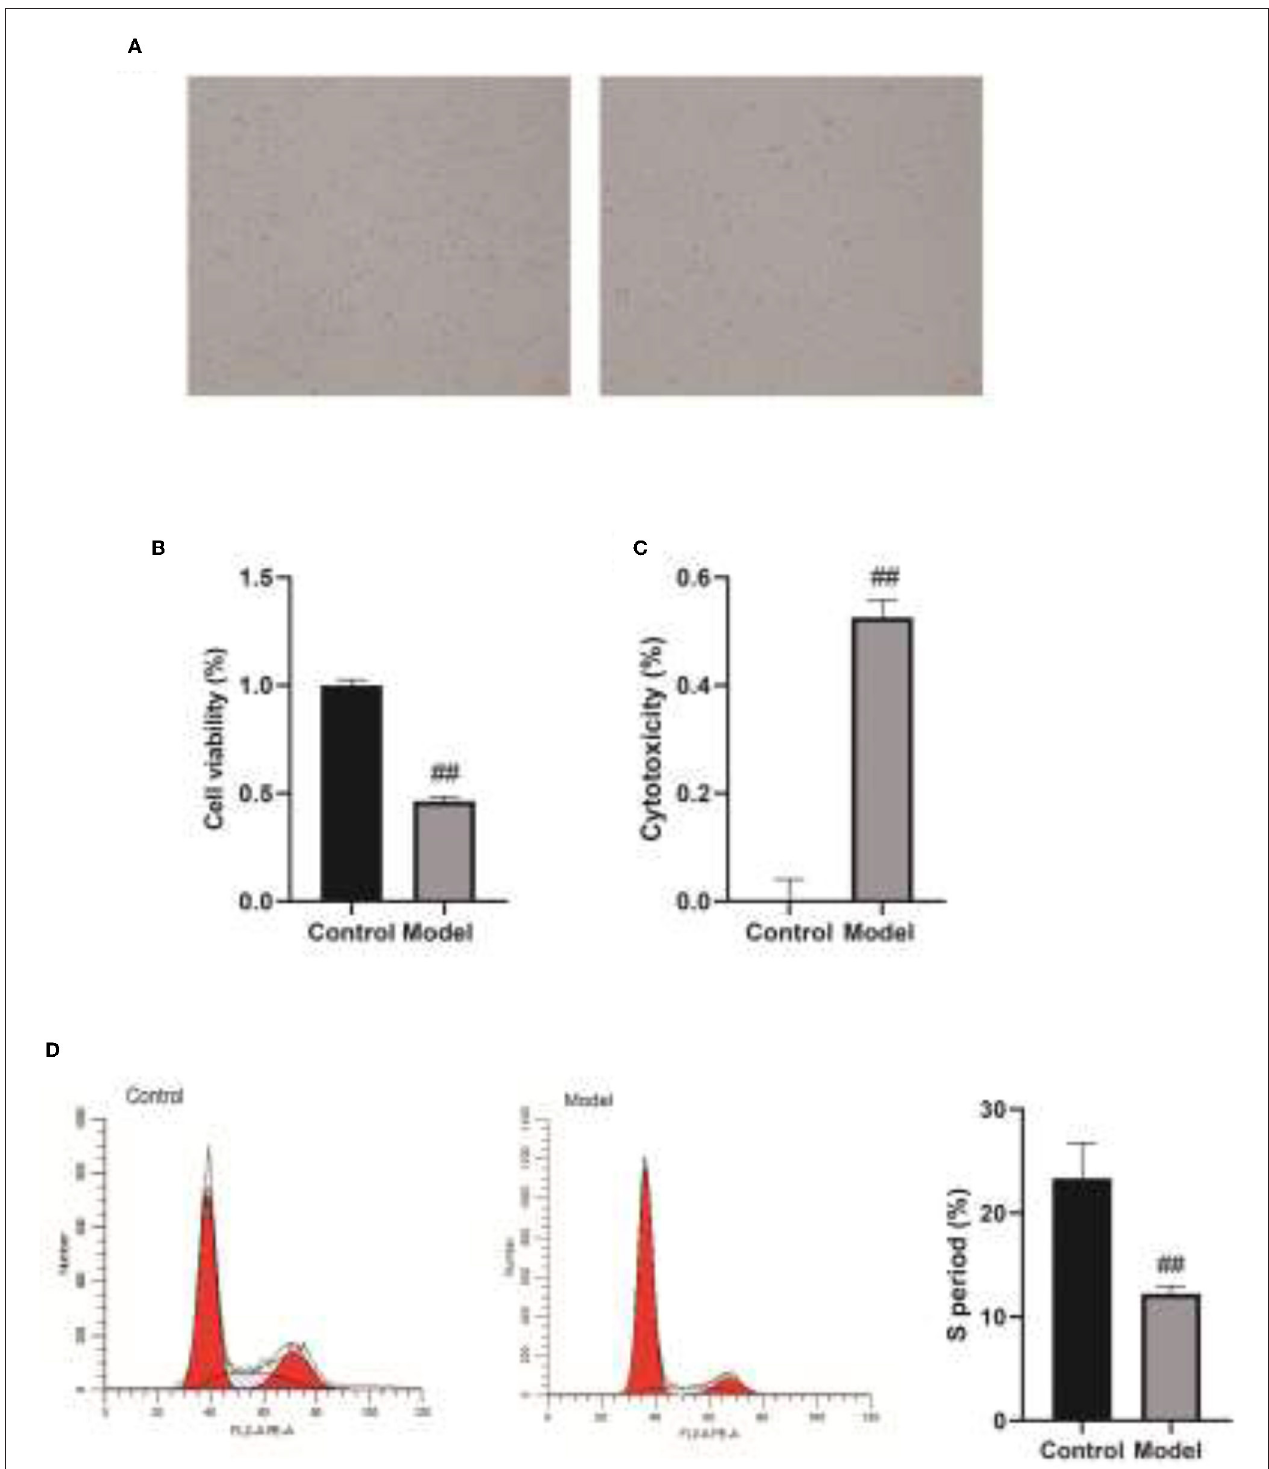
FIGURE 5 | The regulatory effect of Veillonella on the activity of human bronchial epithelial cells. (A) , Human bronchial epithelial cells cultured in vitro . (B) , Cell viability detected by CCK8. (C) , LDH content determination. (D) , Cell cycles detection by flow cytometry. ##, p < 0.01. LDH, lactate dehydrogenase; CCK8, cell counting kit 8.